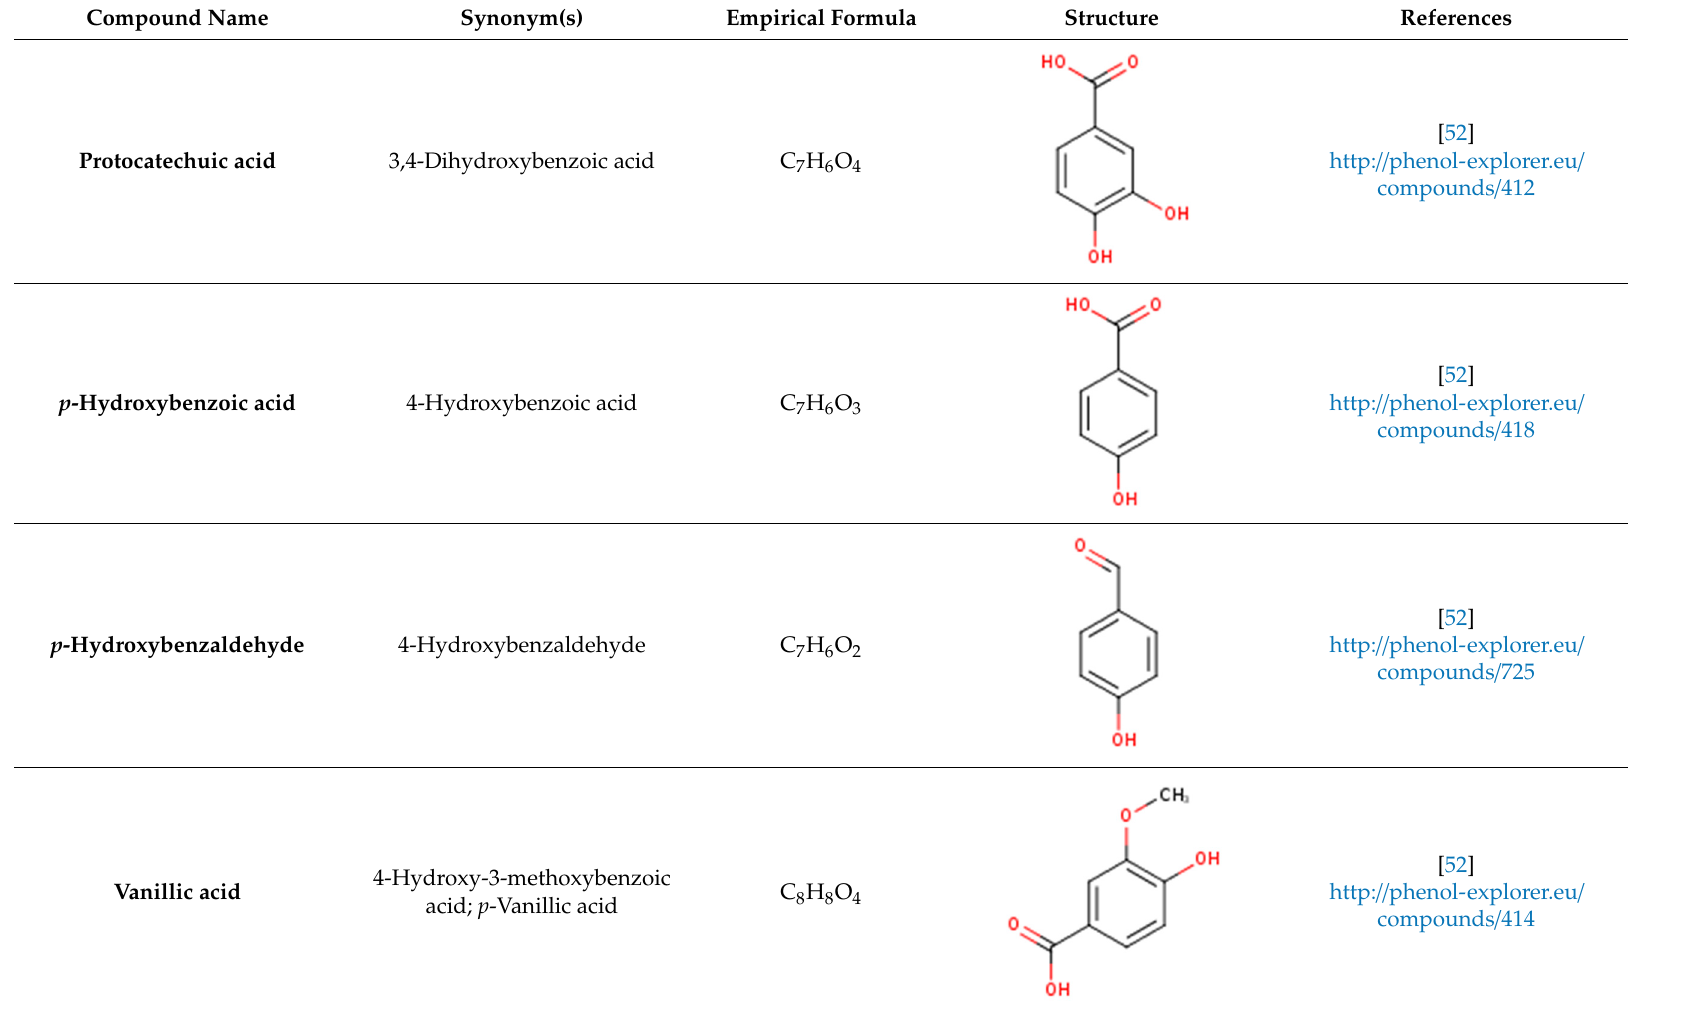
Table 2. Main chemical structures of the phenolic compounds found in the Cucurbita spp.*.